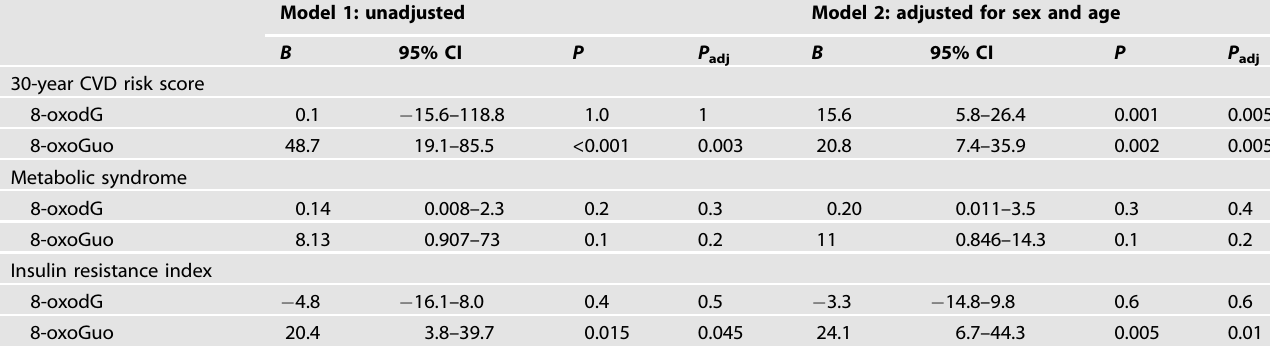
Model 1: unadjusted linear mixed-effects models (continuous outcomes) and generalized linear mixed effect regression models (dichotomous outcome) with familial factor as a random factor. Model 2: sex and age-adjusted linear mixed effects regression models (continuous outcomes) and generalized mixed effect regression models (dichotomous outcome) with familial factor as a random factor (primary analyses). B back transformed beta values re fl ecting the % or increment in dependent variable according to one nm/nM creatinine increment in independent variable (8- oxodg or 8-oxoguo, respectively), CI con fi dence interval, P adj FDR adjusted P value, 8-oxodG 8-oxo-7,8-dihydro-2 ’ -deoxyguanosine, 8-oxoGuo 8-oxo-7,8-